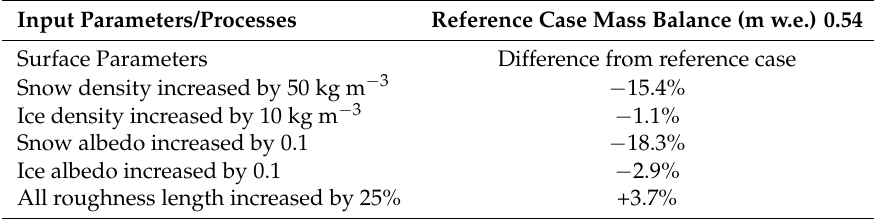
Table 6. Results of sensitivity analysis of the model for the period of 5 May 2014–15 November 2014. Input